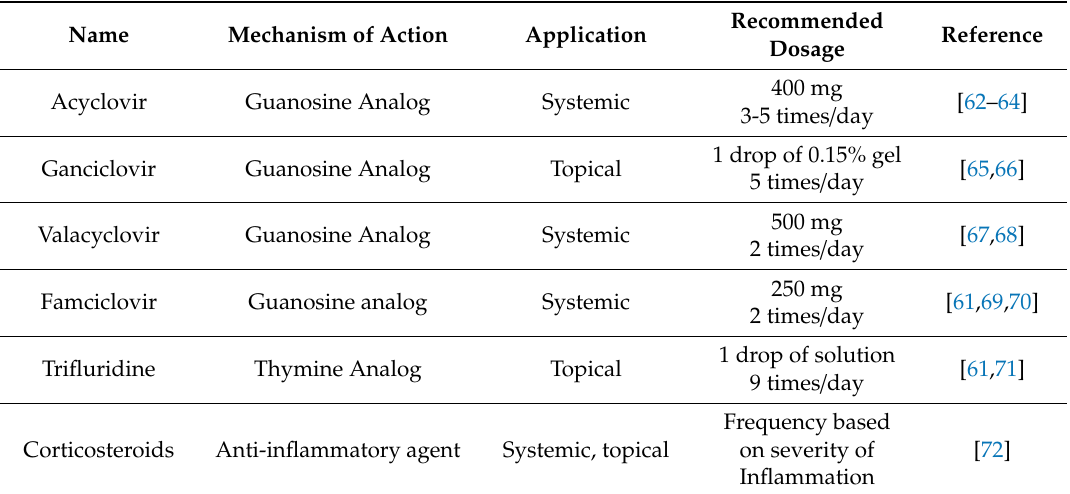
Table 1. List of approved drugs for ocular HSV-1 infections in the USA. Only the topical gels are approved specifically for the treatment of keratitis [61]. The name of the drug, its mechanism, how it is given, common dosages, and references are provided for each entry in the